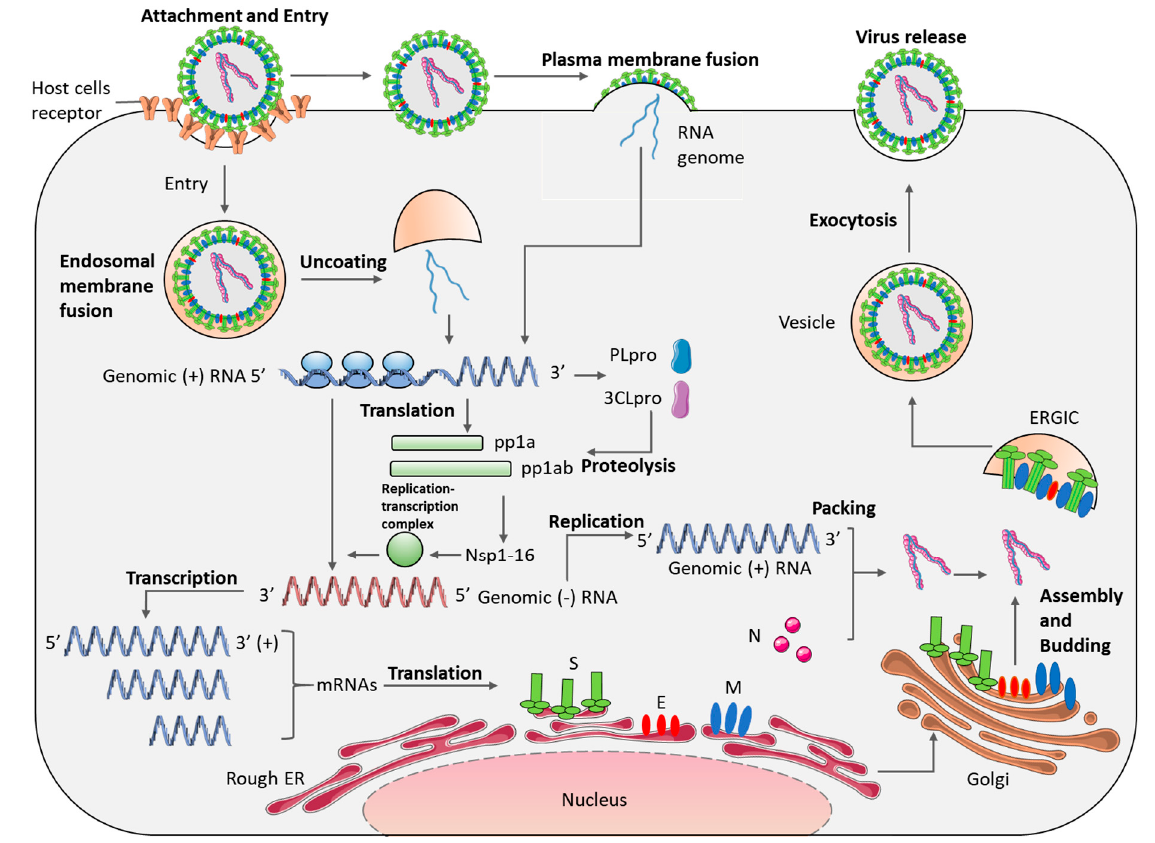
Figure 3. Coronavirus lifecycle. After binding to cellular receptors, coronaviruses enter cells and release their RNA genome. The RNA is transcribed and translated into proteins or replicated to form new RNA, which is assembled into viral particles and released from the cell (ERGIC: ER–Golgi intermediate compartment, ER: endoplasmic reticulum, S: Spike, E: envelope, M: membrane, N: nucleocapsid, nsp: non-structural proteins).